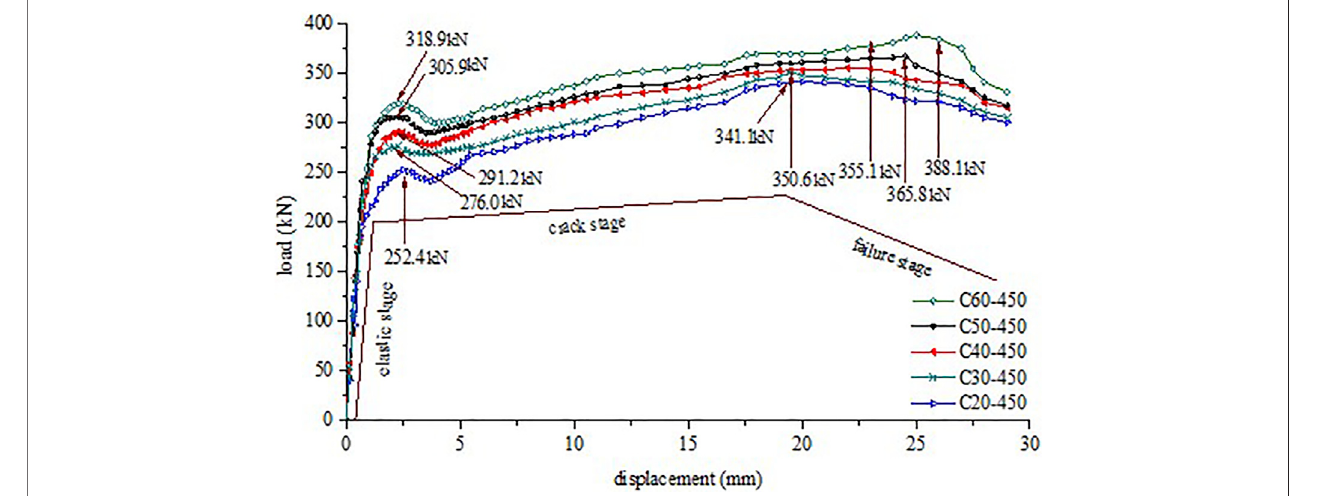
FIGURE 13 | In fl uence of CSG on